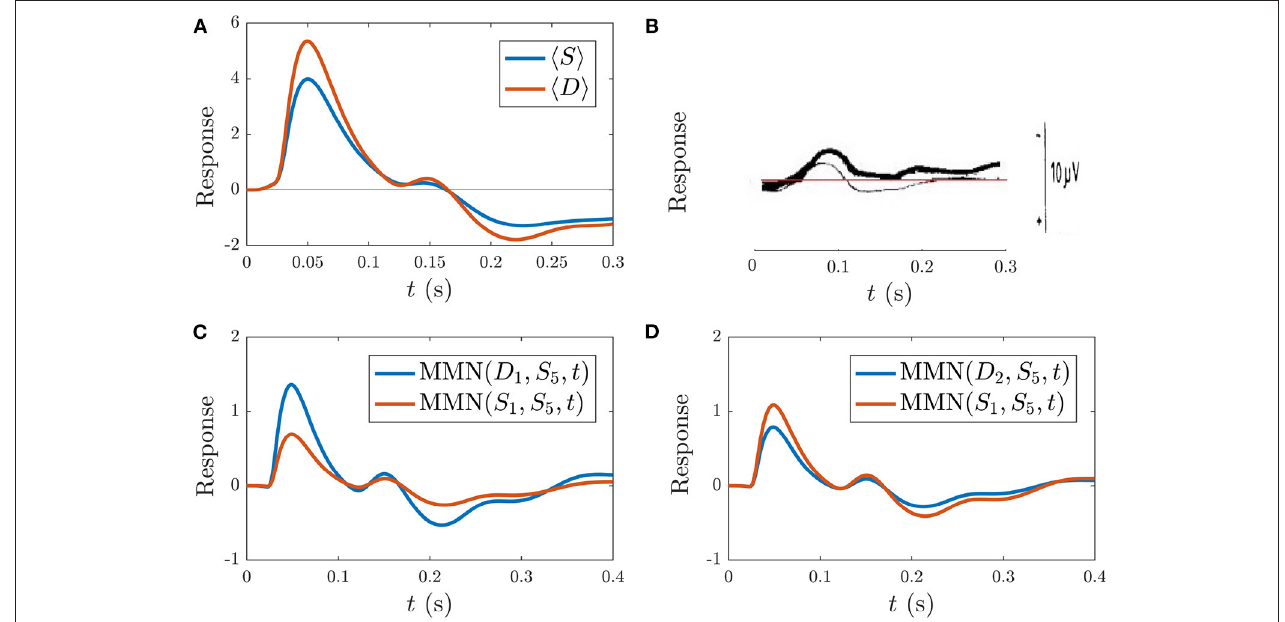
FIGURE 10 | Simulations vs. experiment (Sams et al., 1984) for the sequences discussed in section 3.4.1. (A) Model S and D (see legend), each averaged over all presentations during the typical sequence of standards with occasional deviants. (B) Corresponding experimental findings from this same sequence, adapted from Sams et al. (1984), where D is indicated with the thin line and D is indicated by the bold line. The experimental scale bar at right is 10 µ V in length. (C) Model findings for the MMN( D 1 , S 5 , t ) and MMN( S 1 , S 5 , t ) (see legend) corresponding to the sequence (4 S ) S 5 D 1 S 1 . (D) Model findings for the MMN( D 2 , S 5 , t ) and MMN( S 1 , S 5 , t ) corresponding to the sequence (4 S ) S 5 D 1 D 2 S 1